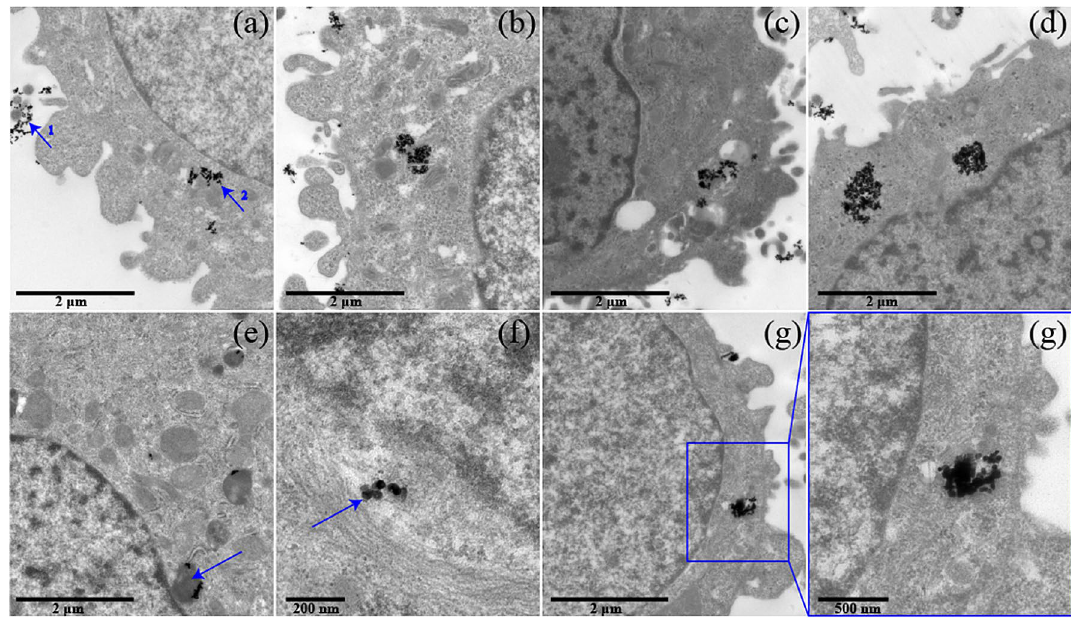
Figure 2. Localization in A549 cell of nAg control ( a ), CA-nAg ( b ), FA-nAg ( c ) and TA-nAg ( d ) with incubated concentration of 75 μg ml −1 , and CA-nAg ( e ) and TA-nAg ( g ) with incubated concentration of 10 μg ml −1 . ( f ) CA-nAg in endoplasmic reticulum. 1 and 2 marked in ( a ) for surface associated AgNPs and intracellular AgNPs,